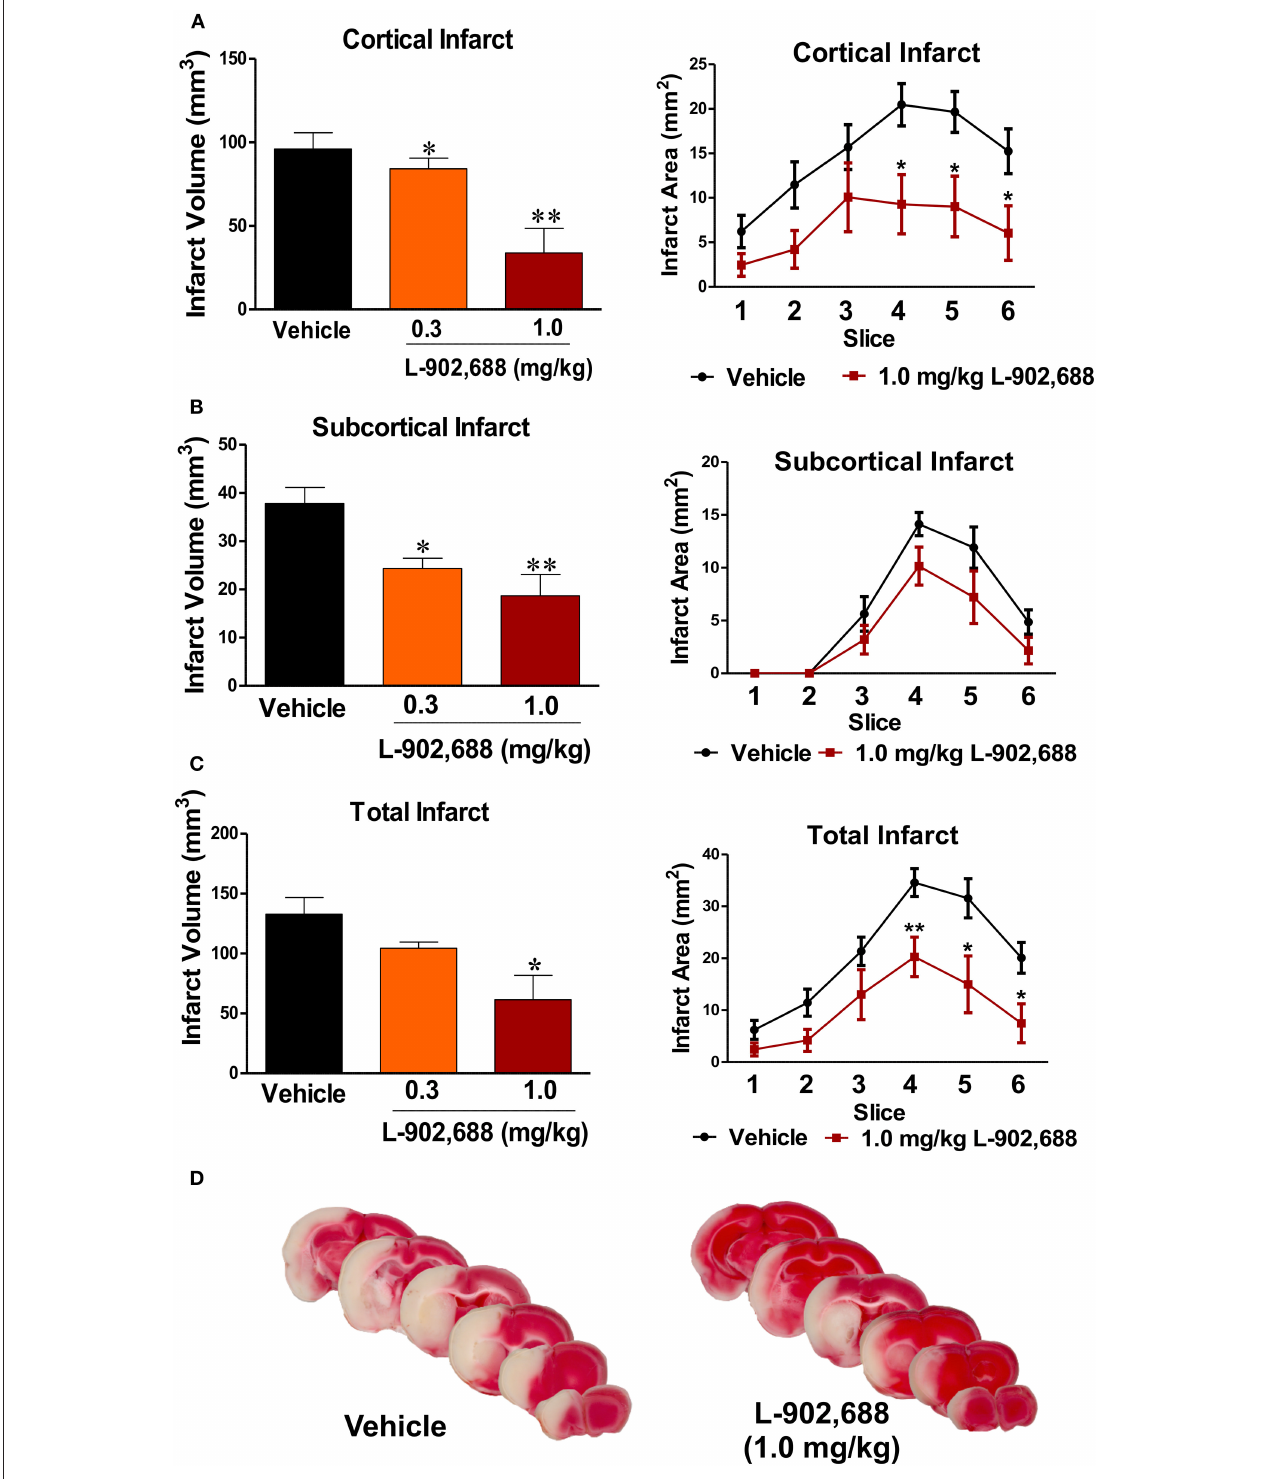
FIGURE 1 | Reduced Infarct with EP4 Agonist L-902,688. Using a one-way ANOVA with a Dunnett’s Multiple Comparison posttest, we found that 1.0 mg/kg significantly reduced infarct size in both the (A) cortex ( p = 0.0012) and the (B) subcortex ( p = 0.0018). (C) Total infarct volume is reduced with 1.0 mg/kg L-902,688 (Students’ t -test * P = 0.0123) (D) Representative TTC-stained slices from a vehicle- and L-902,688-treated brains after 24h of reperfusion following 90min of MCAO. Vehicle ( n = 10), 0.3 mg/kg ( n = 8), and 1.0 mg/kg ( n = 8) L-902,688. * P < 0.05 and ** P < 0.01 compared with vehicle.